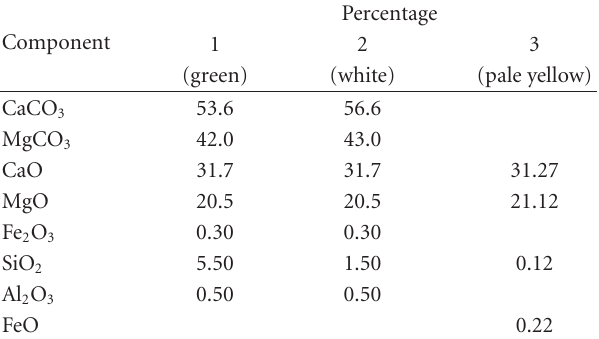
Table 1: Chemical composition of dolomite.